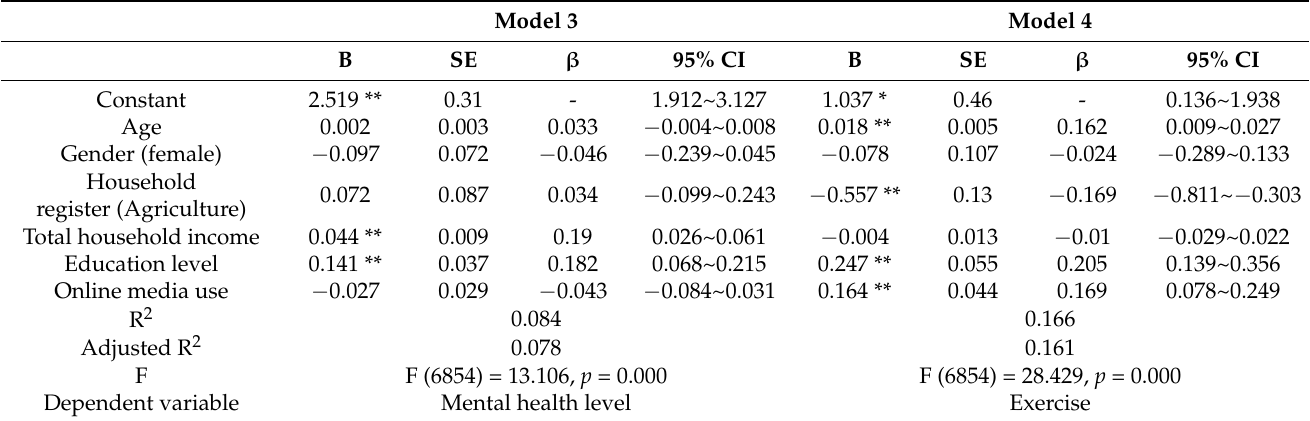
Table 8. Results of Mediating Effect Analysis.